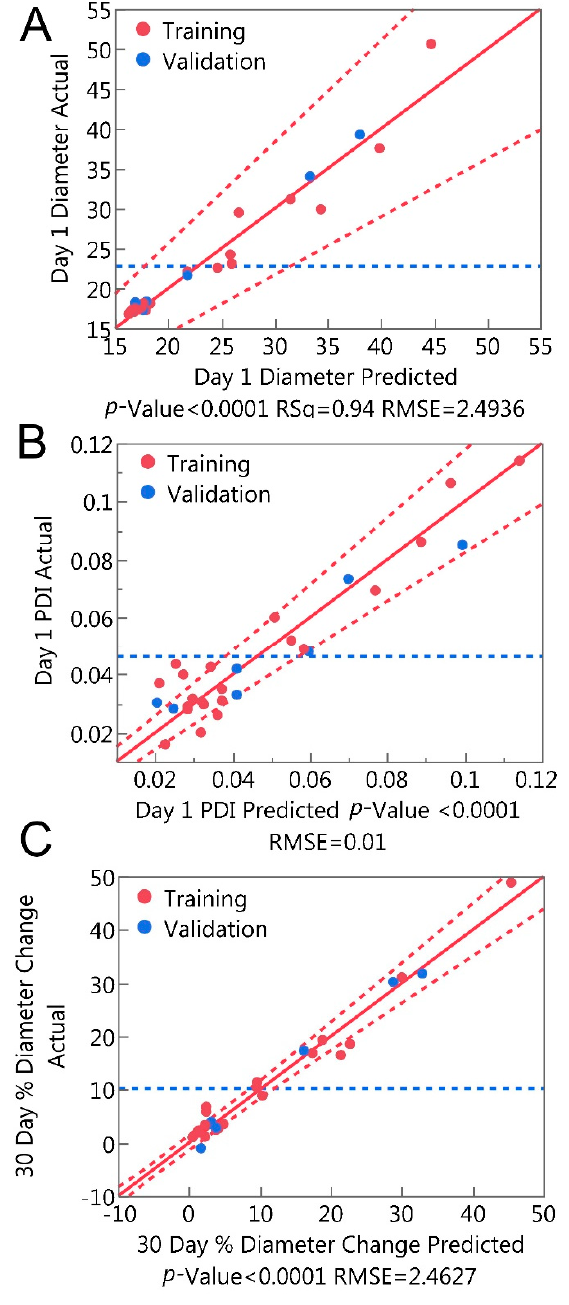
Figure 1. Multiple linear regression models predict microemulsion ( A ) Day 1 diameter; ( B ) Day 1 PDI; ( C ) 30 day % diameter change as a function of microemulsion composition.